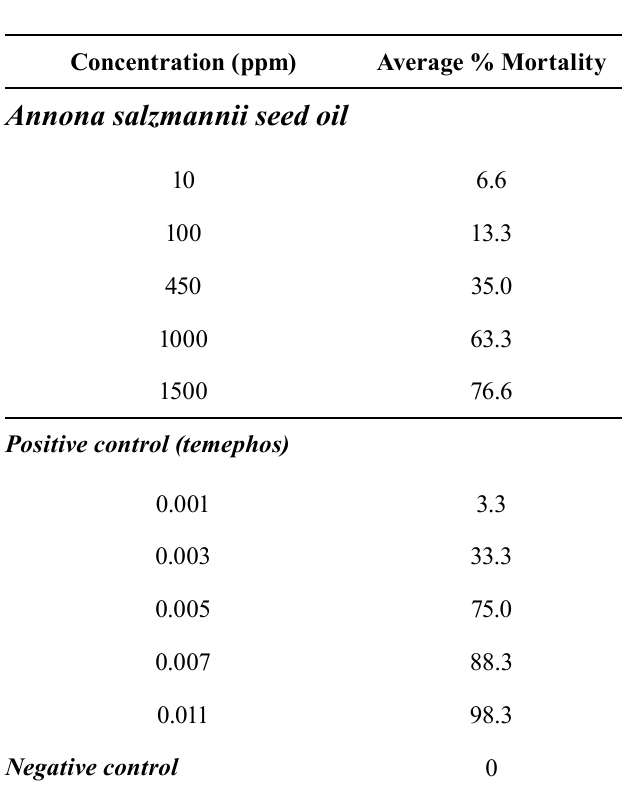
TABLE II – Percentage mortality of Aedes aegypti mosquito larvae in the control and experimental group after exposition to Annona salzmannii seed oil for 24 h